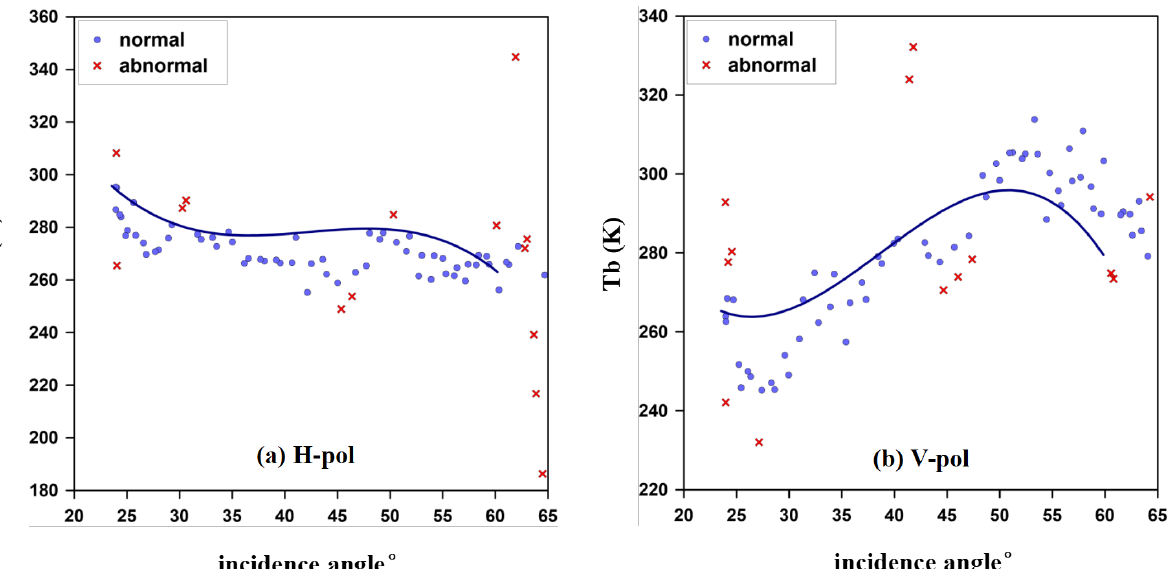
Figure 4. Angular measurement. ( a ) HH polarization; ( b ) VV polarization. The blue line is the third-order polynomial fit of all Tb values of one point from different snapshots, the blue spot is uncontaminated Tb, and the red cross is contaminated Tb,